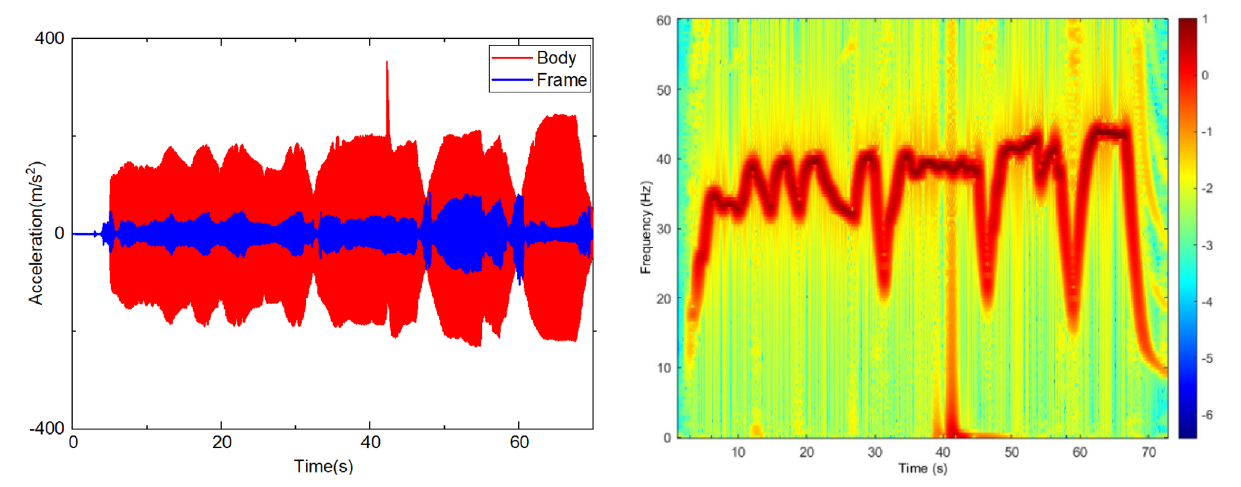
Fig. 10 Acceleration and corresponding SFT results in operating